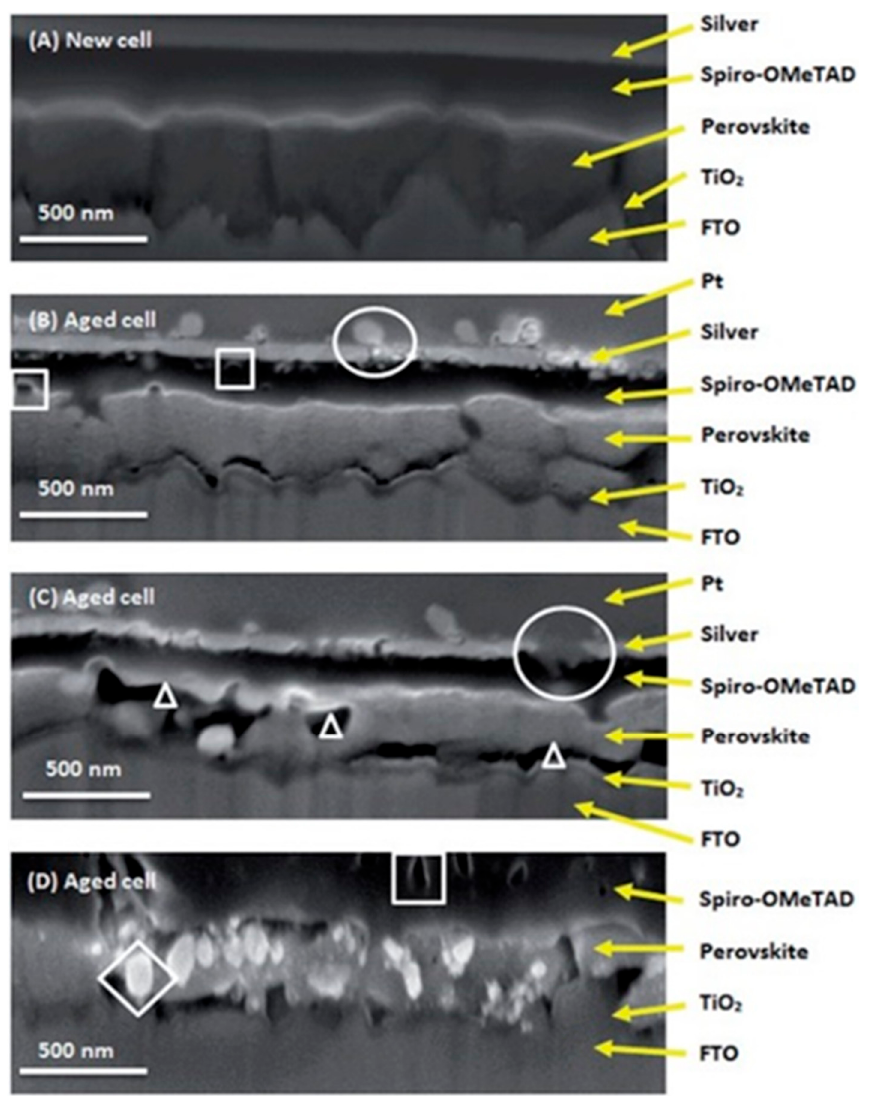
Figure 5. Cross-sectional FIB-SEM images of a ( A ) ( a ) A fresh cell and ( b - d ) cells aged at high temperature (55 °C (85 °C)) and humidity (50%) for 500 h. Degradations in different layers are denoted as voids in the Spiro-OMeTAD layer ( □ ); voids in the perovskite layer ( ∆ ); degraded silver layer ( ○ ) and formation of particles with higher atomic numbers, likely PbI 2 ( ◊ ). Reprinted with permission from [17]